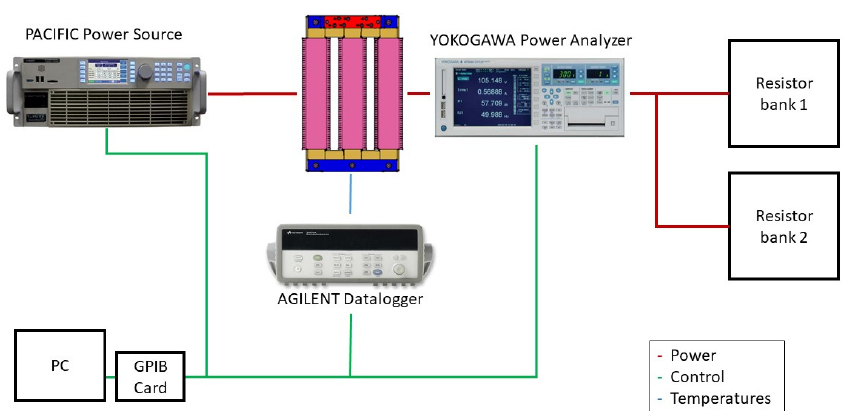
Figure 3. Final setup connection.